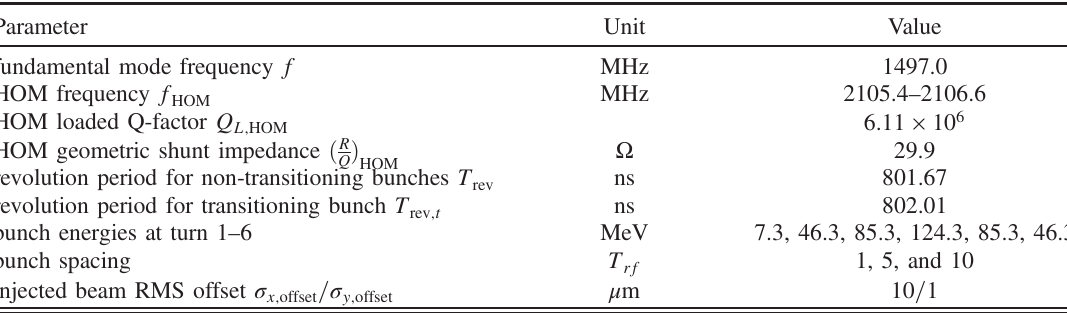
TABLE I. 6-Turn ERL BBU simulation